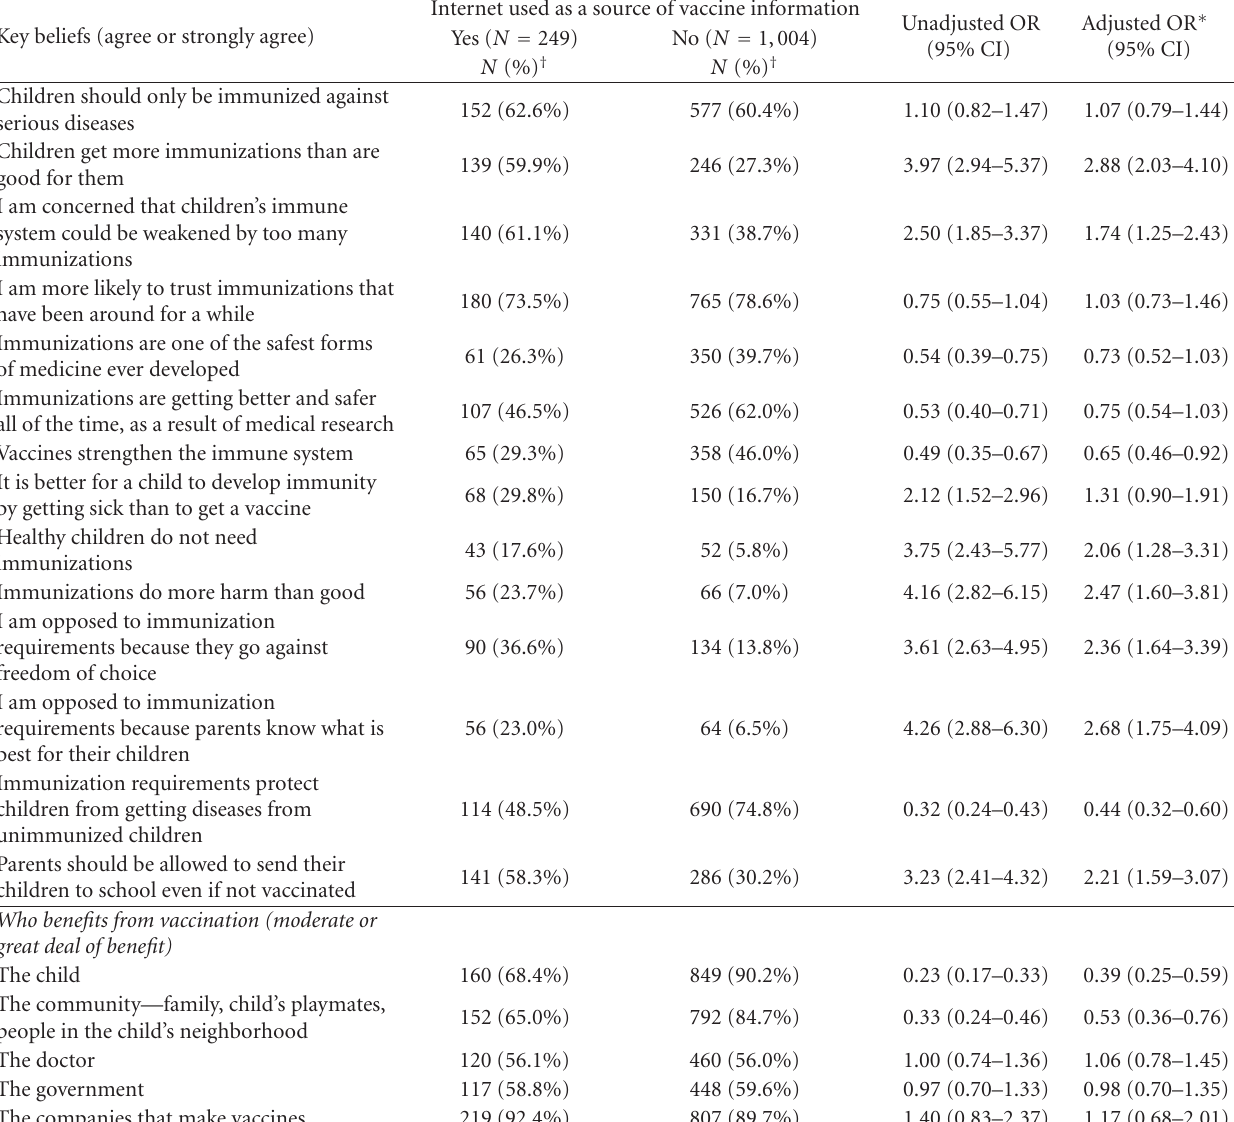
Key beliefs (agree or strongly